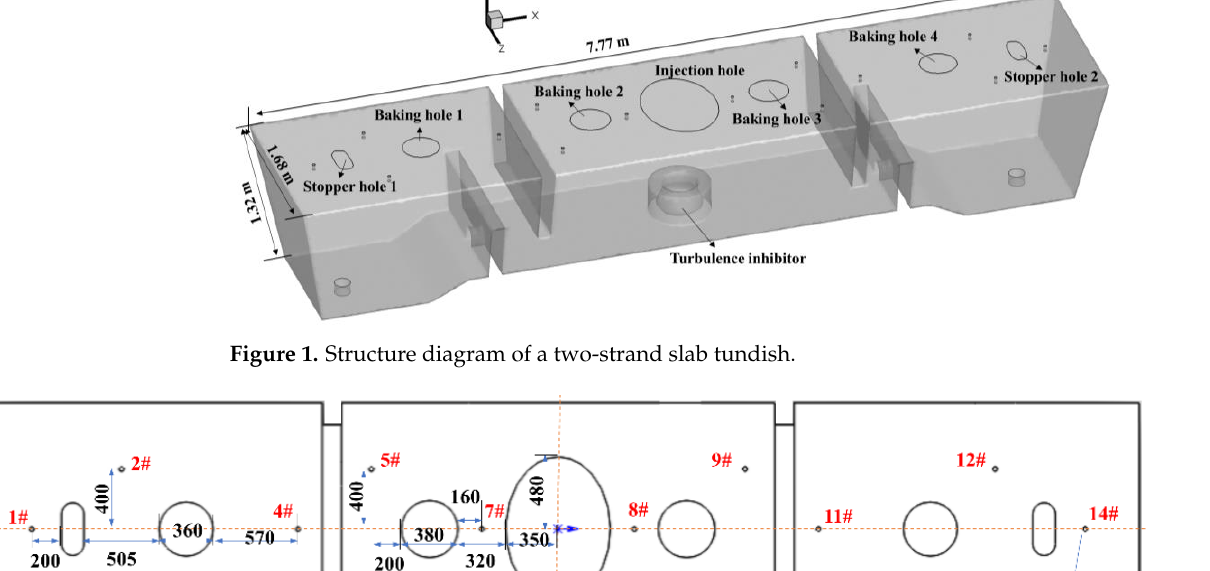
Figure 1. Structure diagram of a two-strand slab tundish.